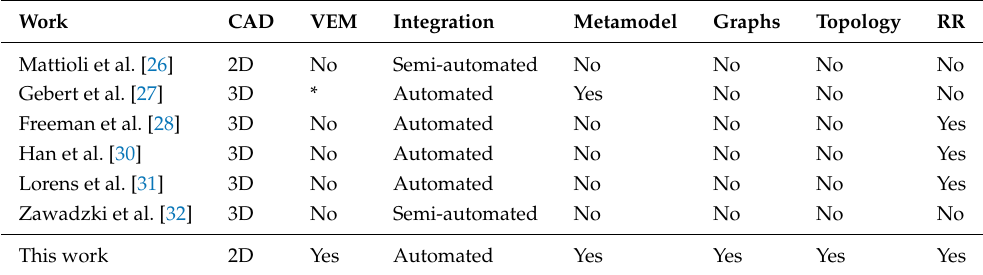
Table 1. Comparative table of characteristics used in this work and in related works.